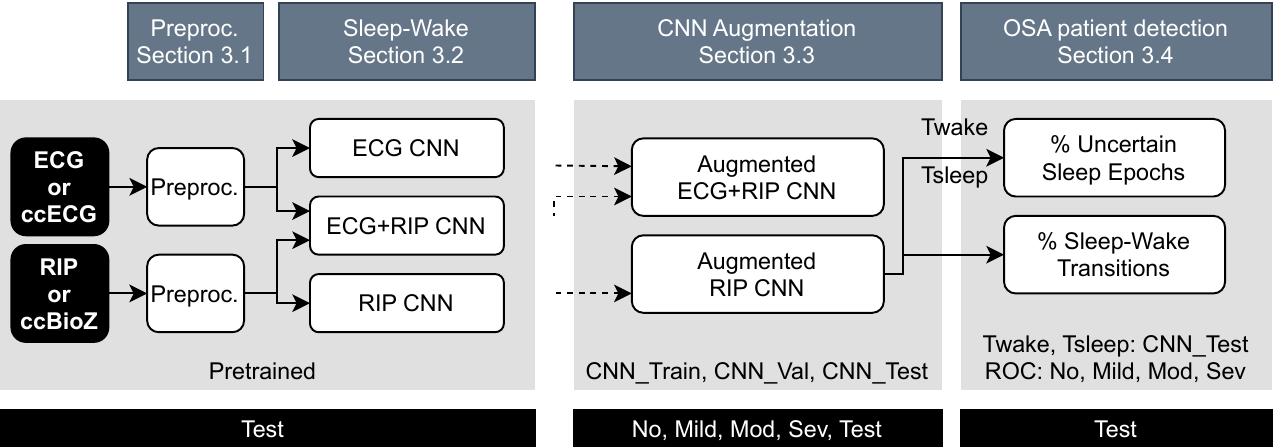
Figure 2. Pipeline of the study. The top blocks refer to the sections elaborating on the procedure below. The grey background blocks indicate the dataset used for model training and optimization. The black blocks at the bottom define the used test data. The data were first evaluated against PSG gold standard, then preprocessed and applied onto the original sleep–wake classifiers. Then, the RIP network was improved and merged with the ECG network. The augmented RIP CNN resulted in sleep–wake predictions, from which the percentage of uncertain predicted sleep epochs was derived, as well as the percentage of sleep stage transitions. These two indices were combined for OSA patient